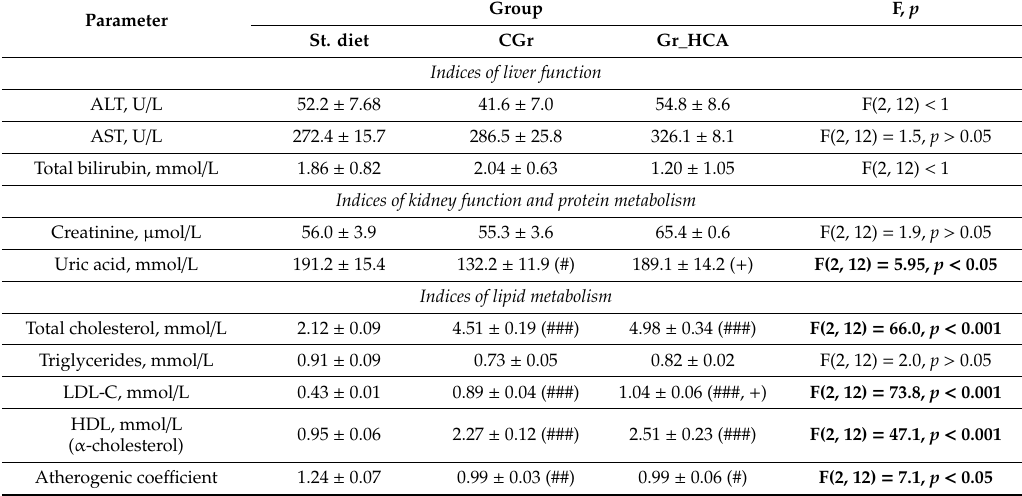
Table 1. E ff ects of the type of a diet on the biochemical parameters of serum in C57Bl / 6J